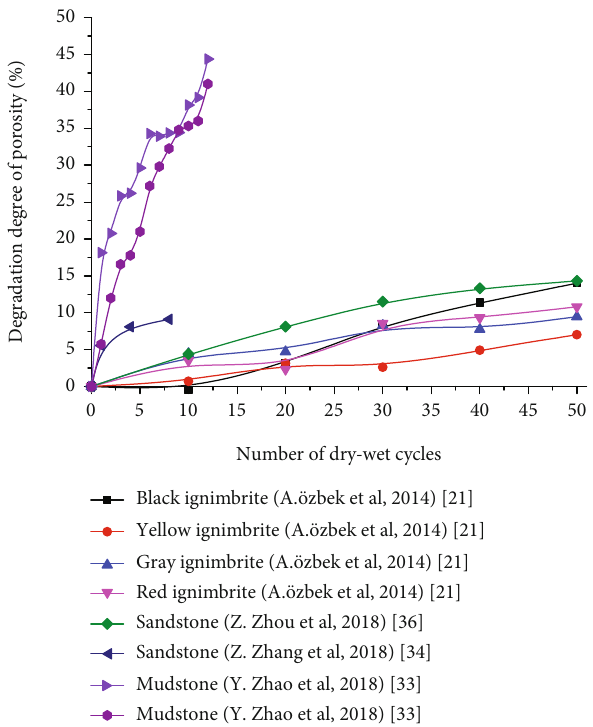
Figure 8: Degradation degree of porosity after di ff erent dry-wet